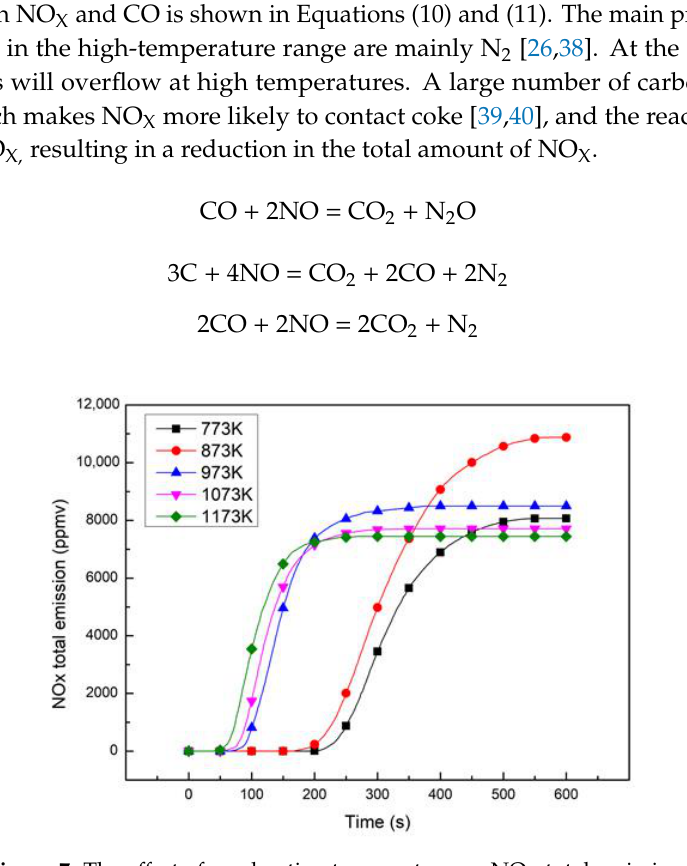
Figure 7. The effect of combustion temperature on NO X total emission.